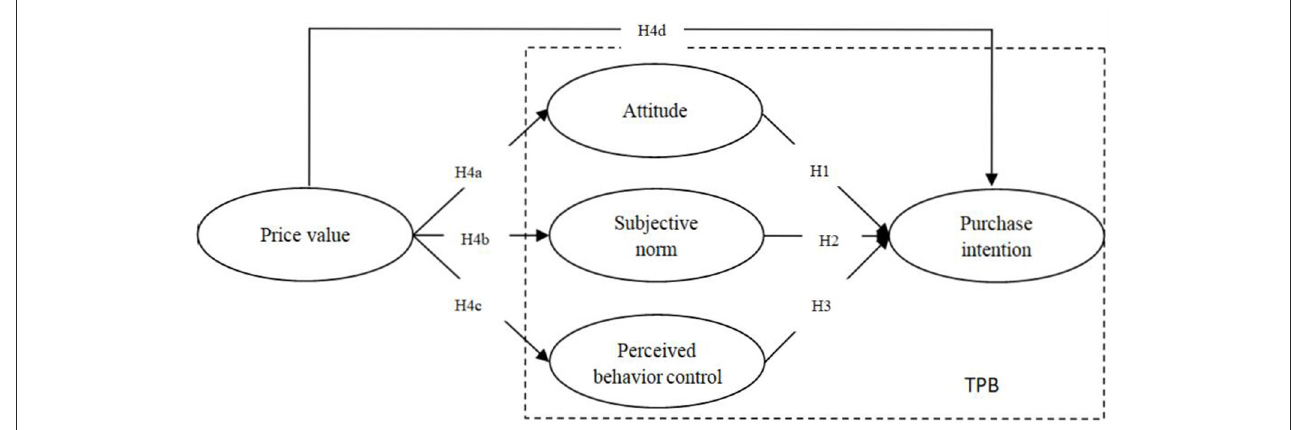
FIGURE1 Conceptual model and